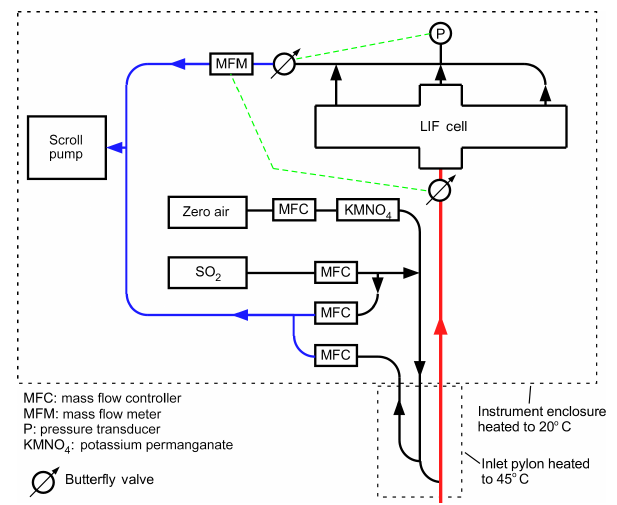
Figure 7. Schematic of flow and calibration system. Red line in- dicates the main inlet, which was housed in a pylon extending 28 cm below the WB-57F skin and heated to 45 ◦ C. Blue lines indicate components at vacuum (<10hPa). Excluding the components in the inlet pylon, all instrument components were housed in an insulated enclosure maintained at 20–30 ◦